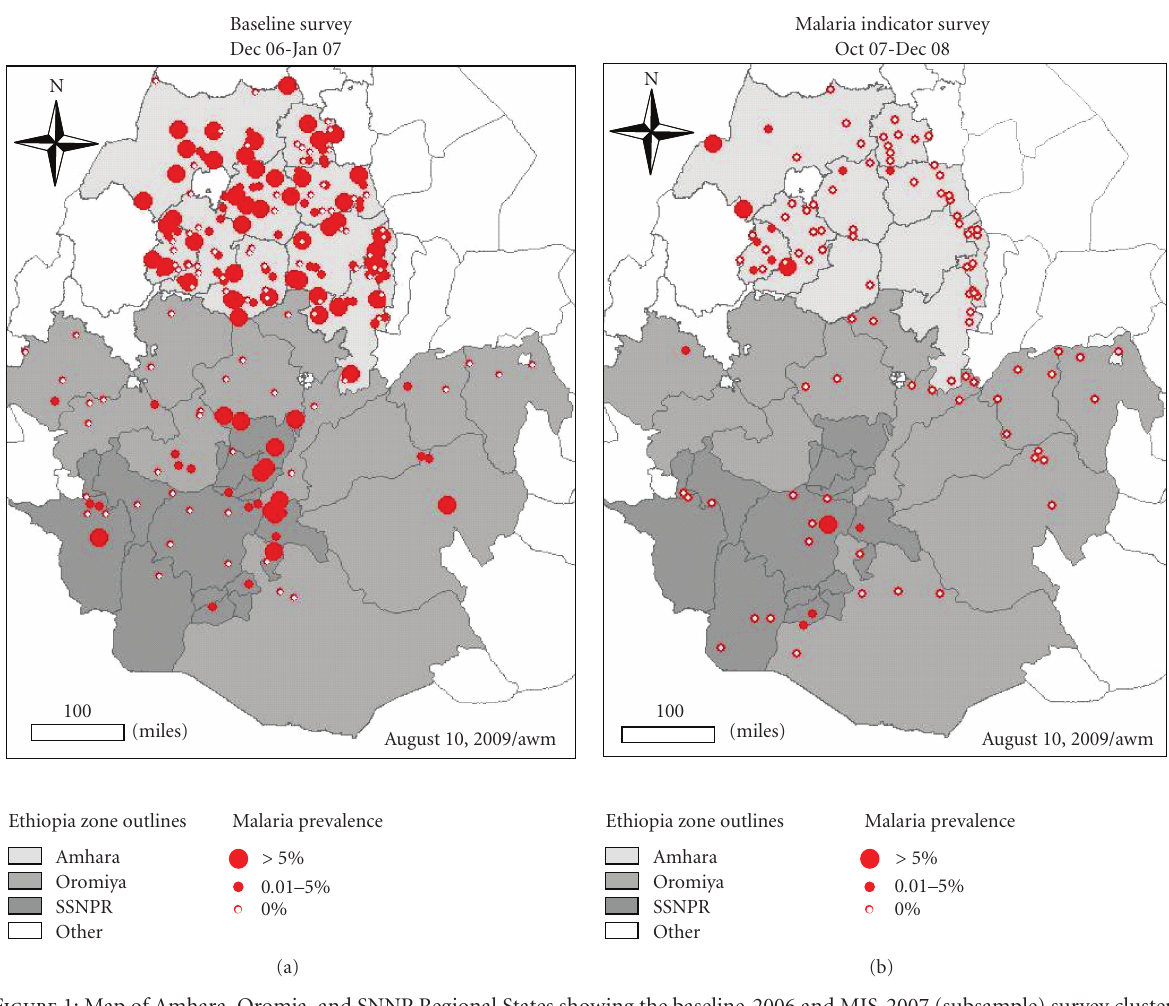
Figure 1: Map of Amhara, Oromia, and SNNP Regional States showing the baseline-2006 and MIS-2007 (subsample) survey clusters.